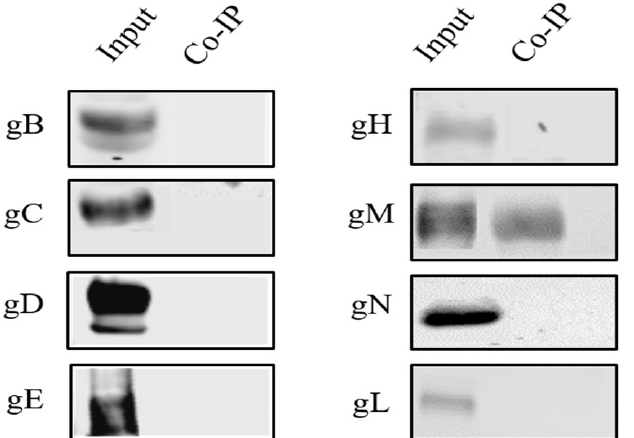
Figure 2. Identification of the glycoprotein interacting with VP8. Lysates from MDBK cells infected with WT BoHV-1 were incubated with rabbit VP8-specific antibody followed by Protein Sepharose G beads. After elution by SDS loading dye, the samples were subjected to SDS-polyacrylamide gel electrophoresis on an 8% (gB, gC, gD, gE, gH, gM) or 15% (gN, gL) gel and transferred to 0.45 µm nylon membranes. Glycoproteins were detected with antibodies specific for gB, gC, gD, gE, gH, gM, gN, or gL, followed by IRDye 680RD goat anti-mouse IgG and IRDye 800RD goat anti-rabbit IgG. Glycoprotein M was found to precipitate with VP8. A fraction of the whole cell lysate was used as input control. Glycoproteins B, gC, gD, gE, gH, gM, gN, and gL were all present in the infected cell lysate.